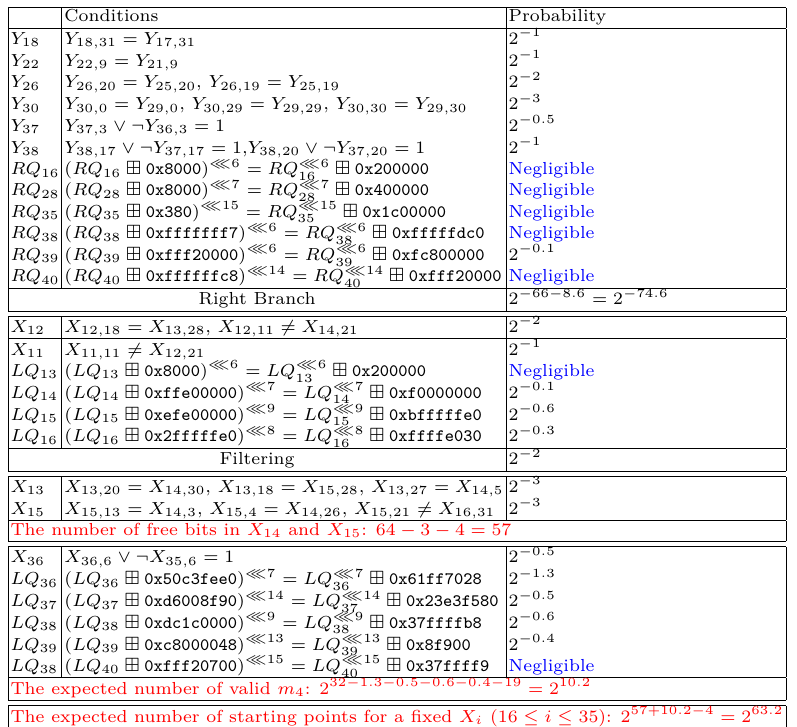
Table 10: Other conditions influencing the attack for the 40-step differential